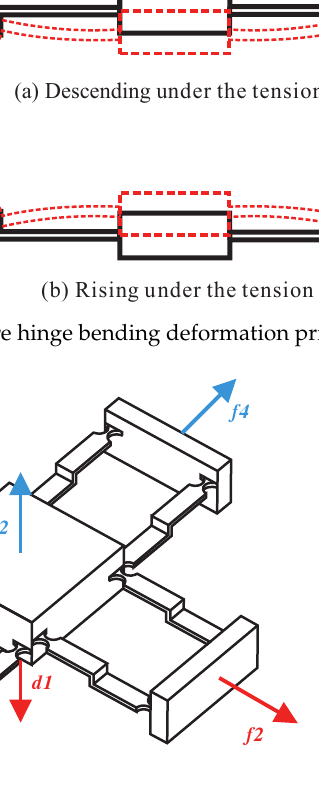
Figure 2. Z bi-directional movement by using Z-shaped flexure